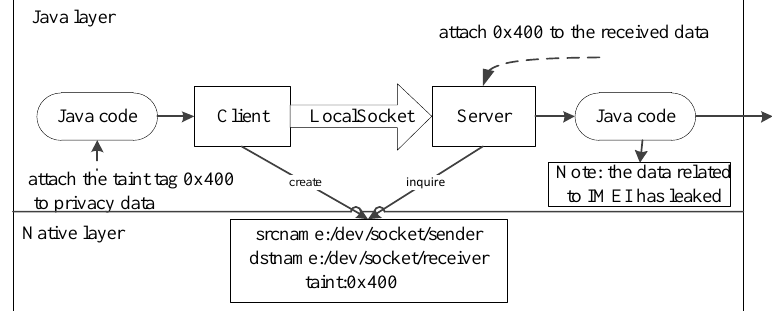
Figure 12. PoC for Case 1.